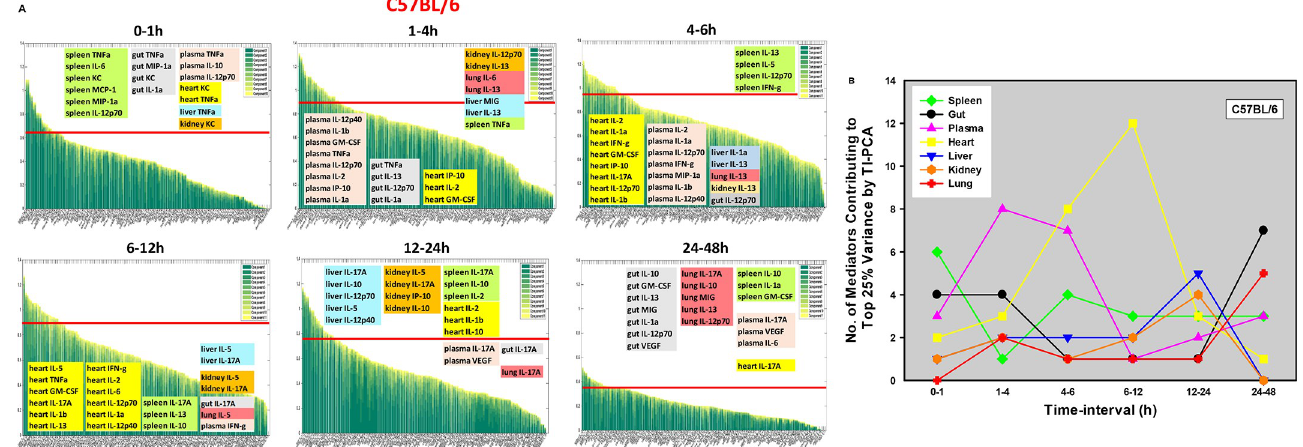
Fig 2. Analysis of endotoxemic C57BL/6 mice by Time-Interval PCA (TI-PCA). Animals (n = 5–8 for each experimental group) were injected with LPS (3 mg/ kg, i.p.). At different time points upon sacrifice, the inflammatory mediators in blood and different organs (liver, heart, gut, lung, spleen and kidney) were measured by Luminex as described in Materials and Methods . Identification of the inflammatory mediators contributing to the top 25% variance of the inflammatory response (shown above the red line in the PCA graph) in all organs together during each of the following six time frames: 0-1h, 1-4h, 4-6h, 6-12h, 12-24h, and 24-48h ( A ) was performed using Time-Interval PCA as described in Materials and Methods . The number of mediators contributing to the top 25% variance of the inflammatory response in each organ as well as in plasma during each time-interval is represented in Panel B .